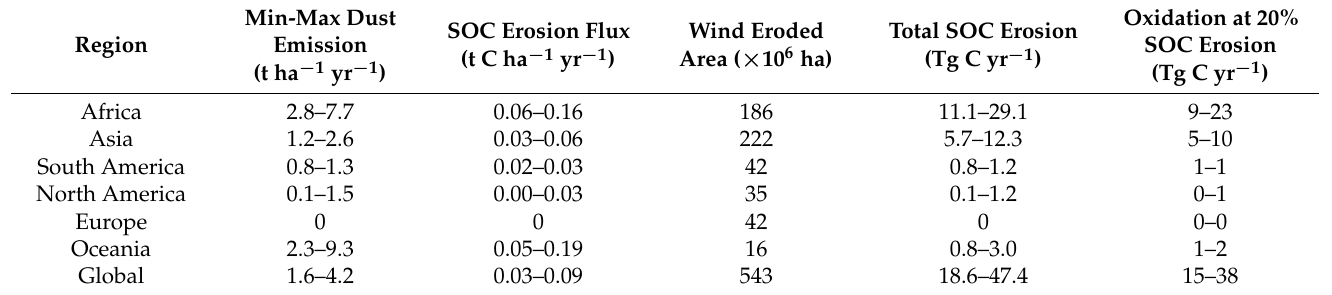
Table 4. SOC erosion associated with dust emission in major regions of the